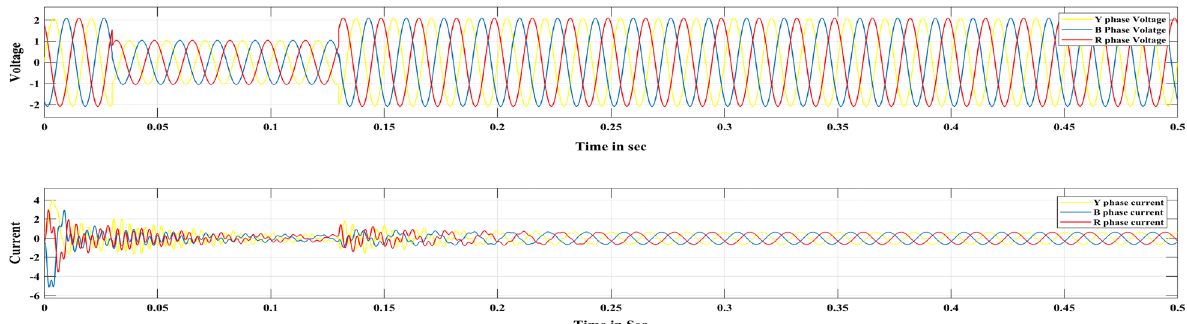
Fig. 11 Voltage and current before enabling the rectifier under unfaulty